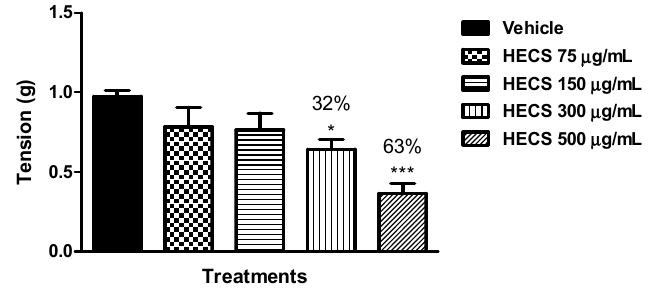
Figure 6. Effect of the hydroalcoholic extract of C. sicyoides— HECS (75, 150, 300 and 500 μ g/mL) on the phasic contractions induced by 3 μ M carbachol in isolated mouse ileum in vitro ( n = 5). The results are expressed as the mean ± S.E.M., and statistical significance was determined by ANOVA followed by Dunnett’s test; * p < 0.05, *** p < 0.001 compared to the control (vehicle). The numbers in percentage in the figure corresponds to the reduction of tension in relation to the control group treated with vehicle.